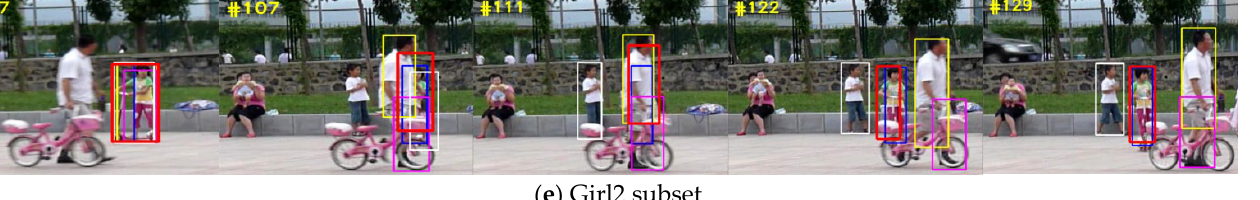
Figure 8. Qualitative evaluation of the proposed TR-Siam and other state-of-the-art trackers on the UAV123 data set. From left to right and top to down are the tracking results on the videos of Car1, Car7, Box, Girl2. Red-Ours Yellow-SiamCAR White-SiamRPN++ Pink-DaSiamRPN Blue-Ground Truth.